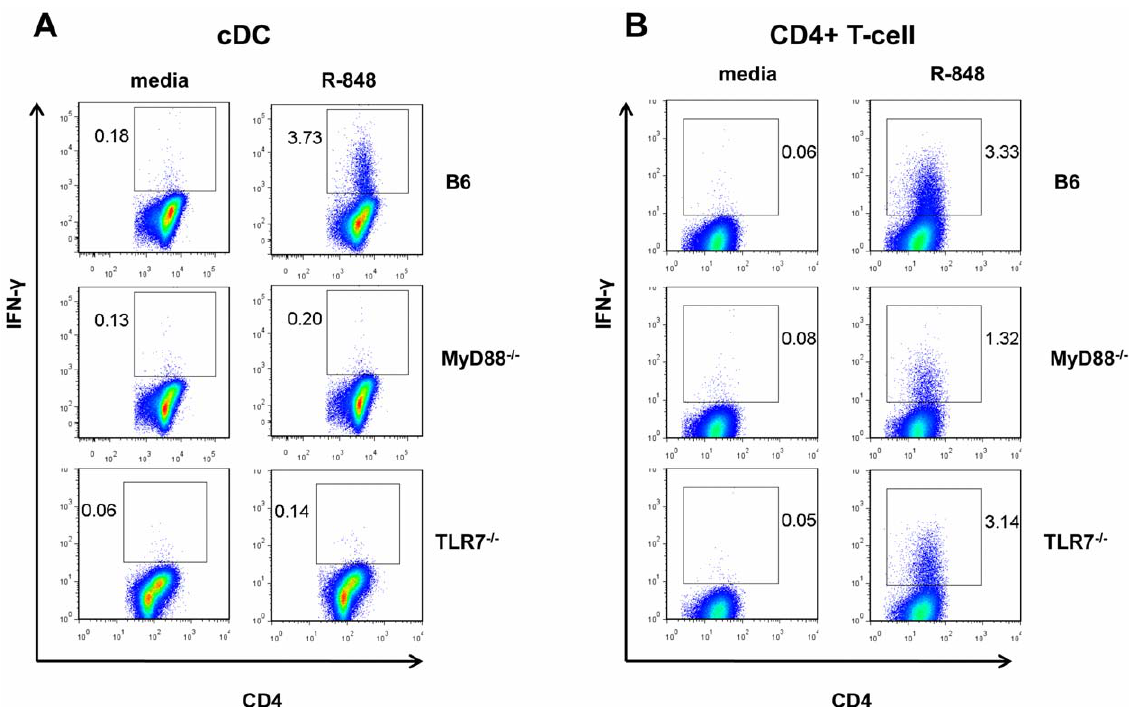
Figure 3. TLR7 signaling in cDCs, and TLR7-independent/MyD88-mediated signaling in CD4 + T-cells, are essential for R-848 induced CD4 + Th1 responses. (A) ICS staining for IFN- c producing CD4 + T-cells in MHC congenic MLRs utilizing B6, MyD88 2 / 2 , or TLR7 2 / 2 cDCs (representative of two independent experiment shown) (B) ICS staining for IFN- c producing CD4 + T-cells in MHC congenic MLRs utilizing B6, MyD88 2 / 2 , or TLR7 2 / 2 CD4 + T-cells (representative of two independent experiments shown). Values shown are the % of IFN- c + conventional CD3 + CD4 +